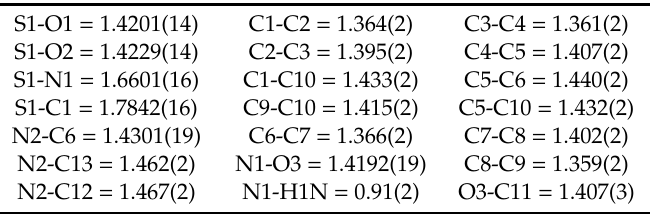
Figure 4. View of the molecular structure of compound 2 along with atoms labelling scheme. Table 1. Selected bond lengths (Å ) for compound 2.